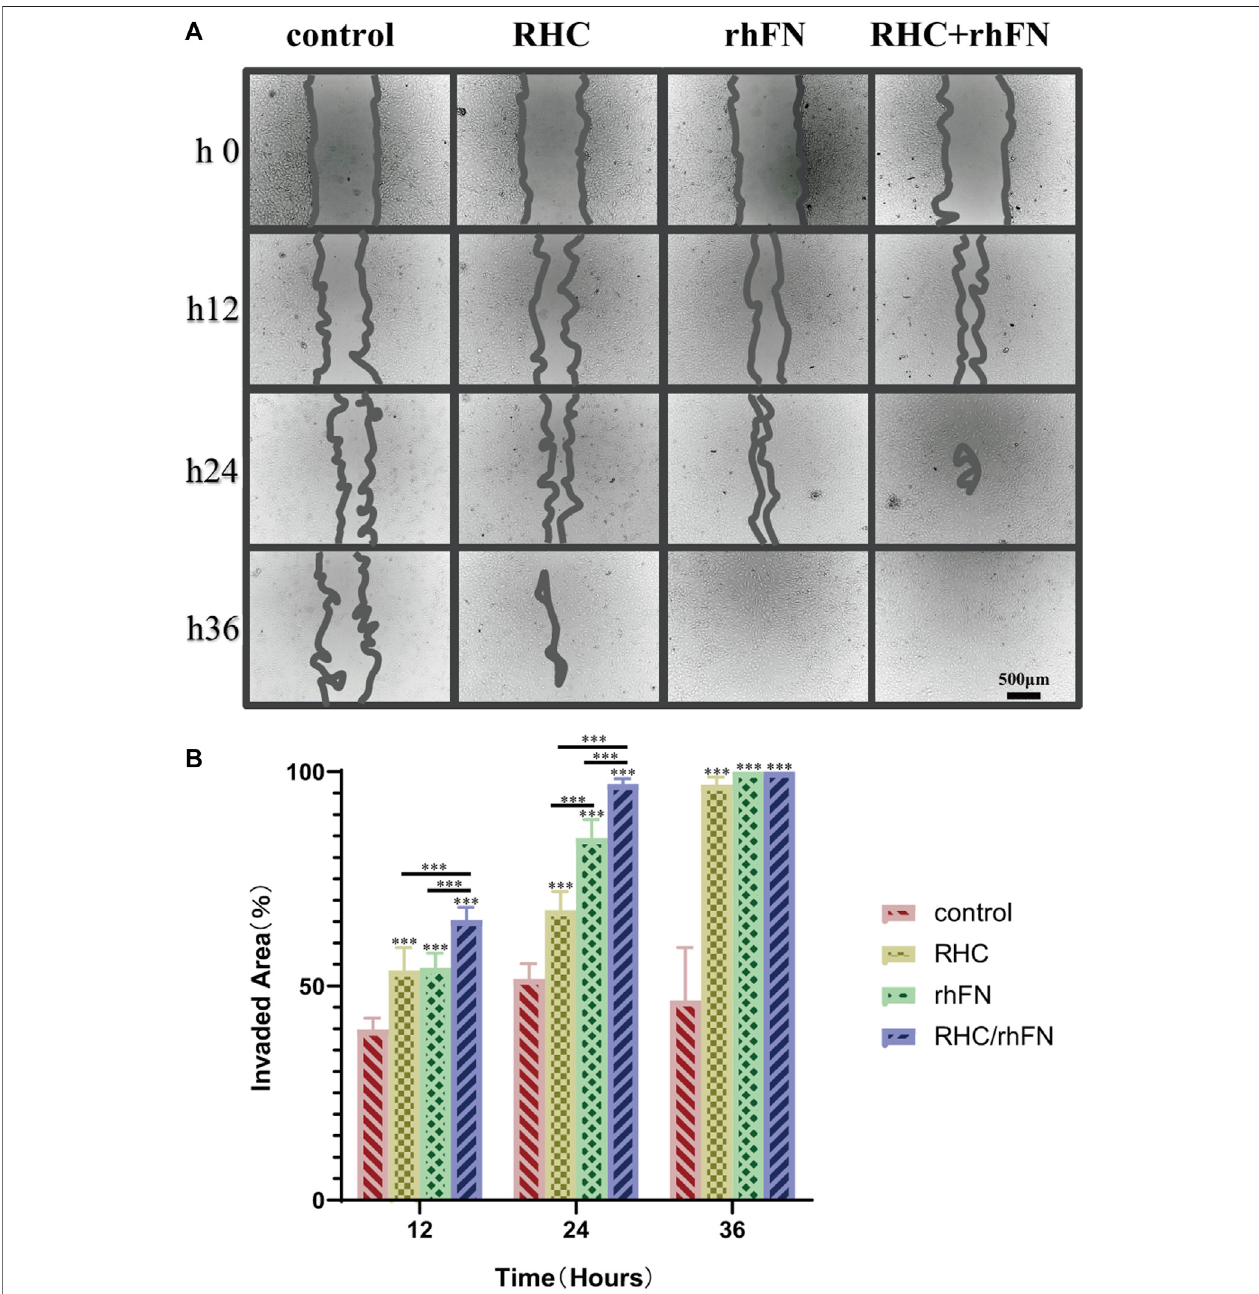
FIGURE 4 | The effect of RHC + rhFN on migration with FCs. (A) Scratch images of FCs at hours 12, 24 and 36. Scale bar = 500 μ m. (B) Calculation and comparison of invaded area at hours 12, 24 and 36. Data are presented as the mean ± SD ( n = 6). Statistical analysis: ppp p < 0.001.